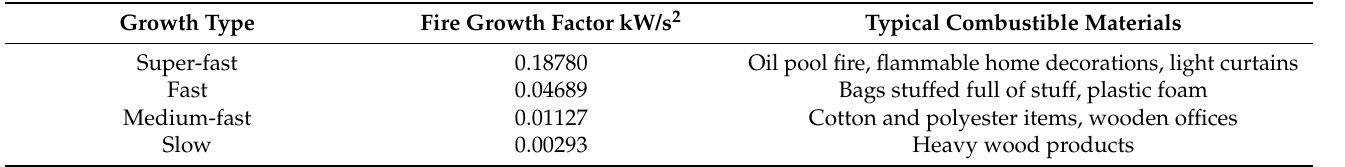
Table 1. Fire growth coefficient.